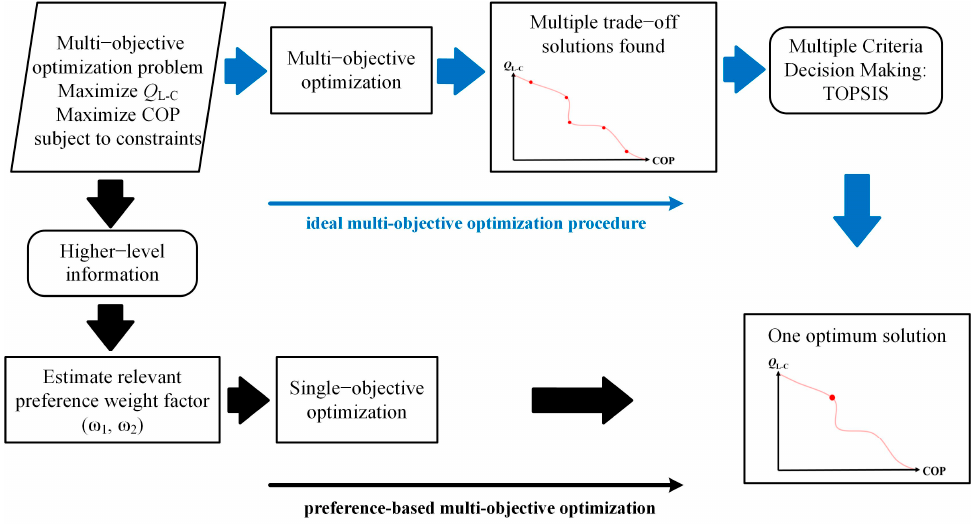
Figure 4. Schematic of the preference-based and ideal multi-objective optimization